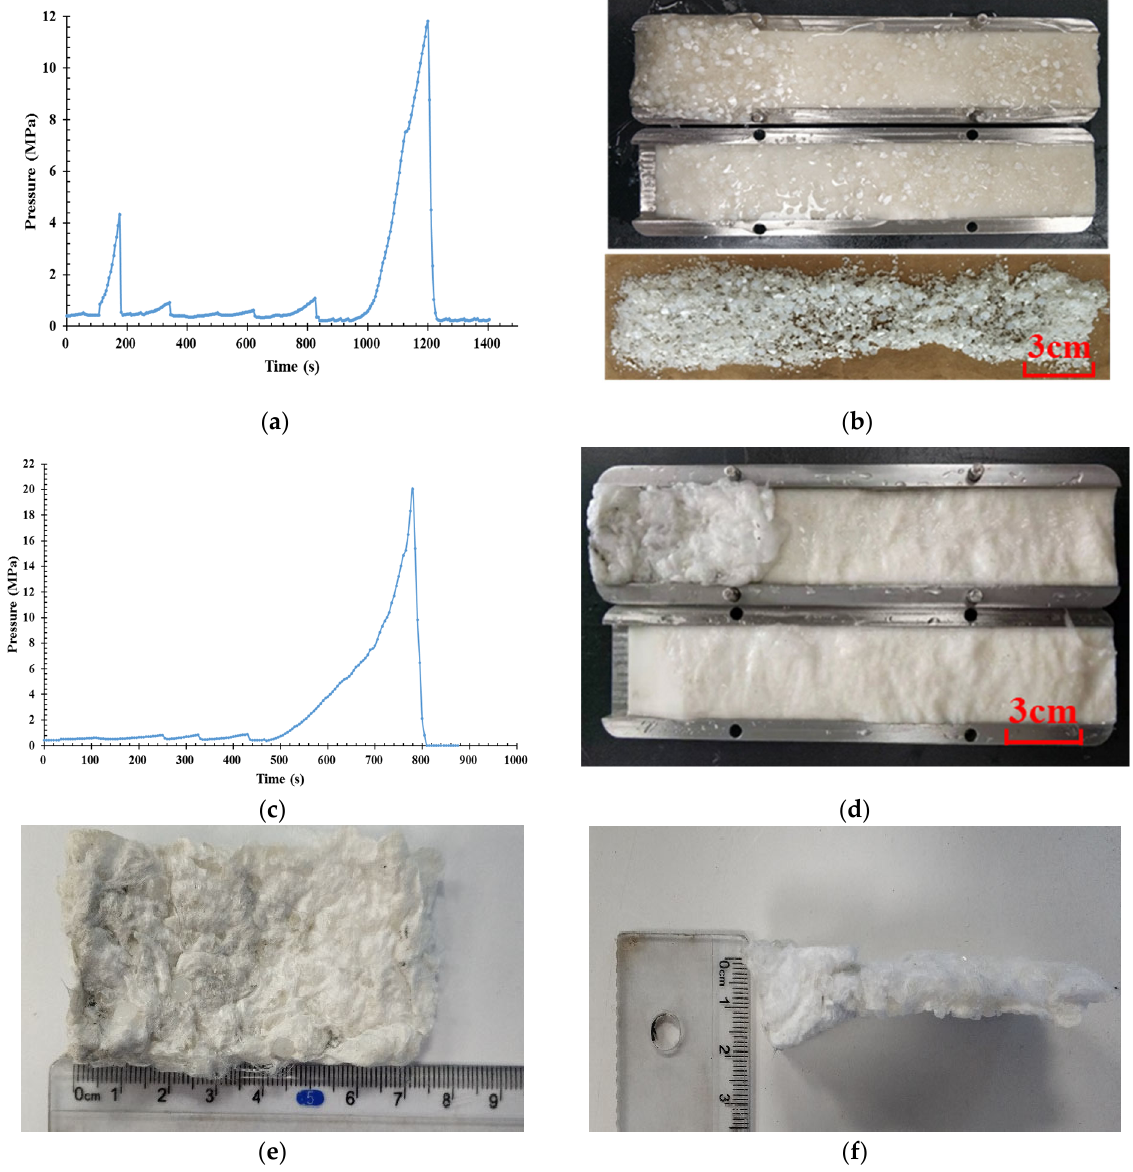
Figure 6. Pressure curve and temporary plugging zone morphology of experiments 4 and 5. ( a ) Pressure curve of experiment 4; ( b ) Temporary plugging zone morphology of experiment 4; ( c ) Pressure curve of experiment 5; ( d – f ) Temporary plugging zone morphology of experiment 5.